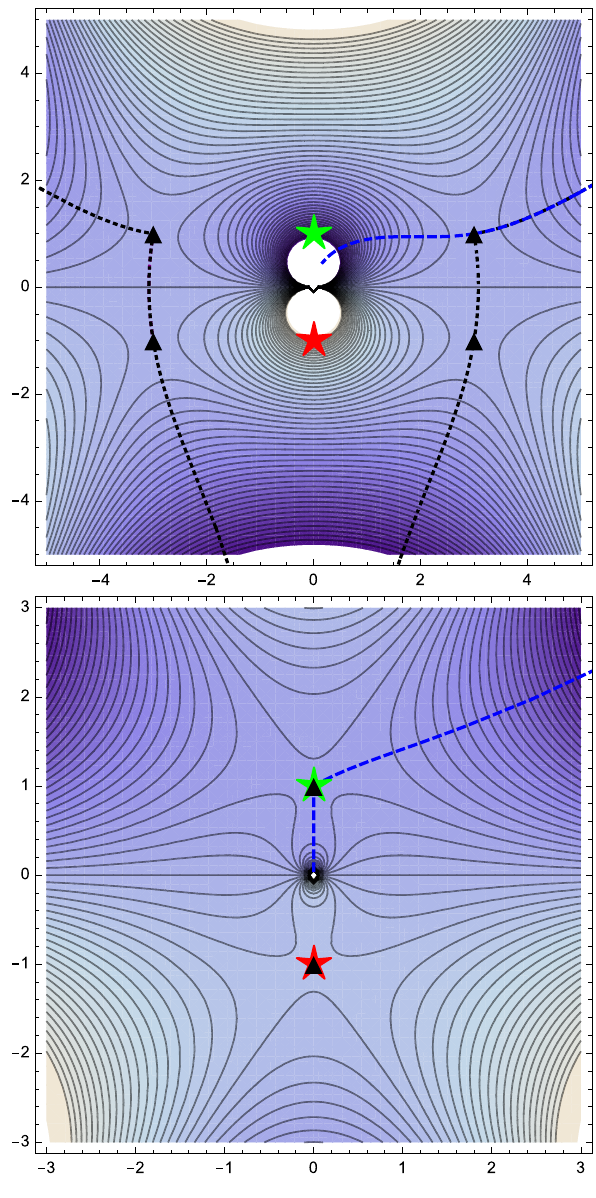
Fig. 5 In the top figure we set q 1 = 10 and (cid:6) = 3. The blue dashed line shows the Lefschetz thimbles on N = ( 0 , ∞ ) whereas the black dashedlineshowstheLefschetzthimbleson N = ( −∞ , ∞ ) .Theredor green star express the standard or inverted Wick rotation, N = + i , − i . On the other hand, in the bottom figure we take q 1 = 1 and (cid:6) =